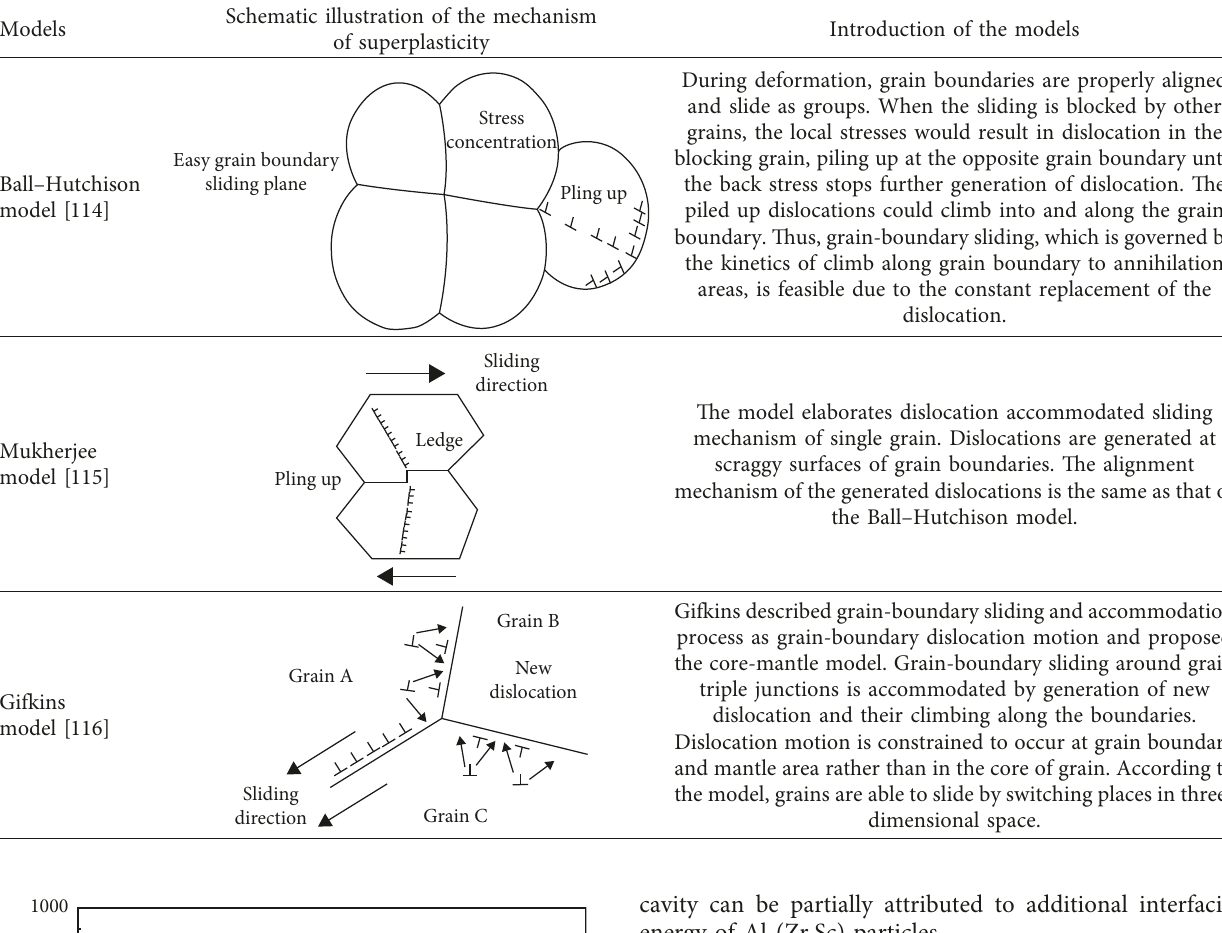
Table 5: Three models for theories of grain-boundary sliding accommodated by dislocation sliding.